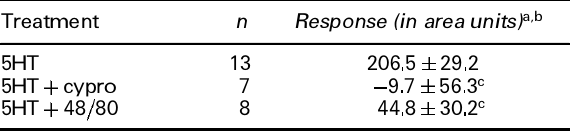
Table 1. Modi® cation of the vasoconstrictive effects of a bolus injection of 5HT (400 m g) on rat hind limb vessels by